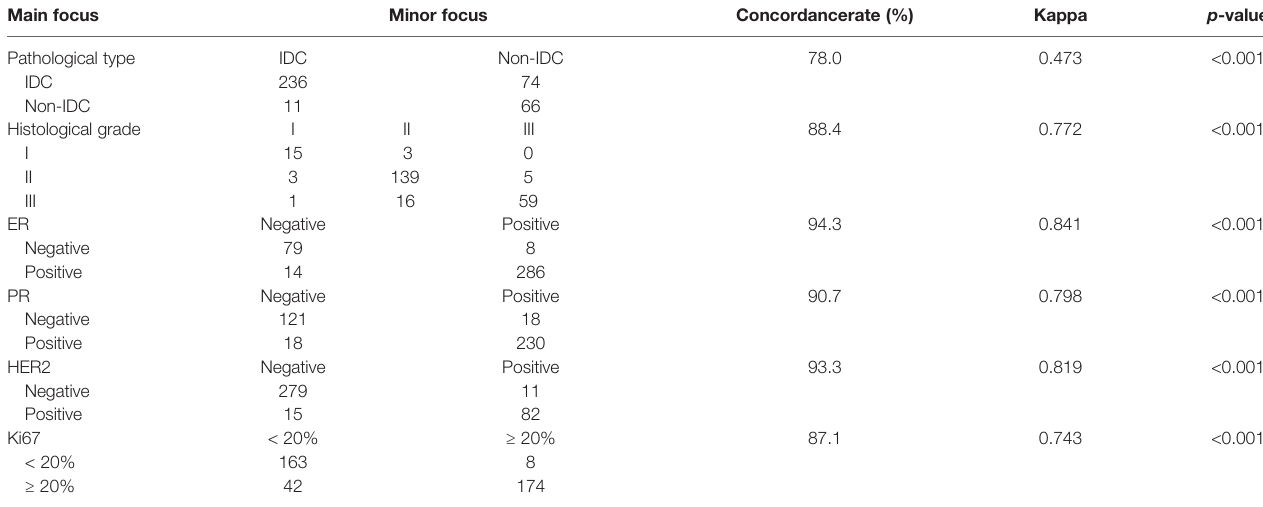
TABLE 2 | Concordance rates of pathological type, histological grade, ER, PR, HER2, and Ki67 status. Main focus